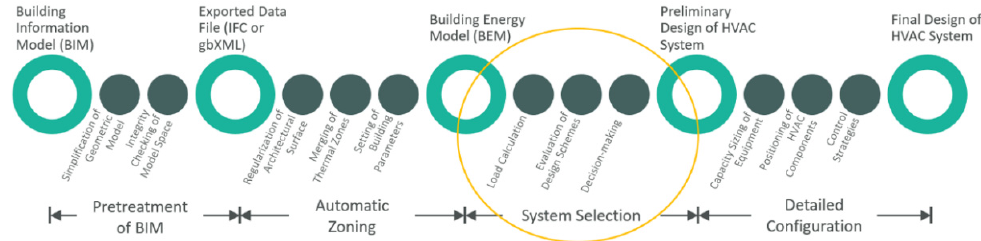
Figure 1. The topic of this paper and the “Automatic design of an HVAC system”.